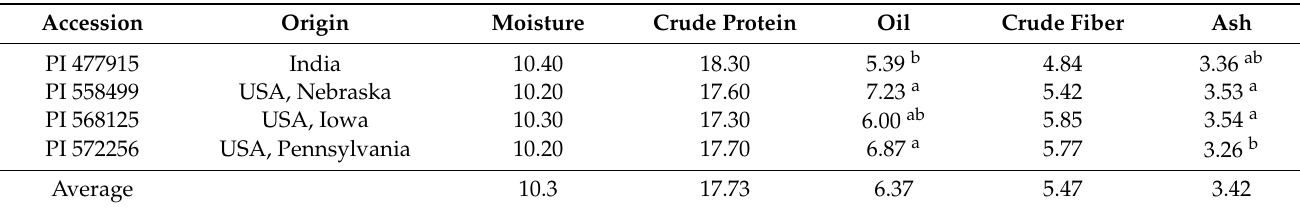
PI = plant inventory. Mean values with different letters (a–c) within the same column differ significantly ( p <